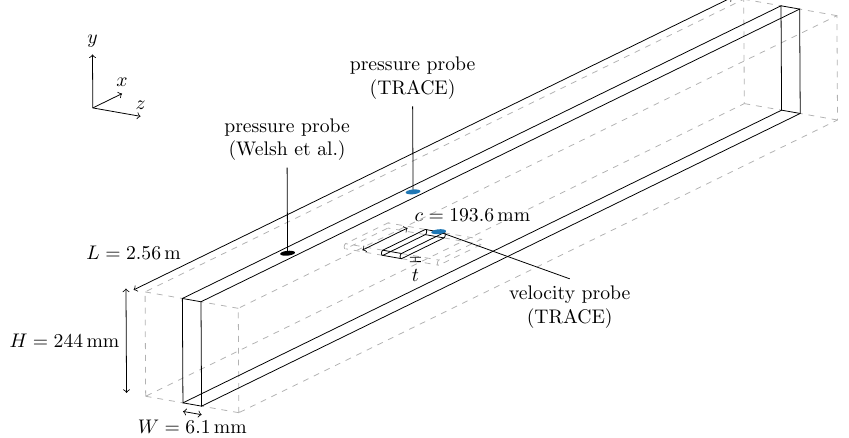
Figure 1. Schematic of the experimental and numerical